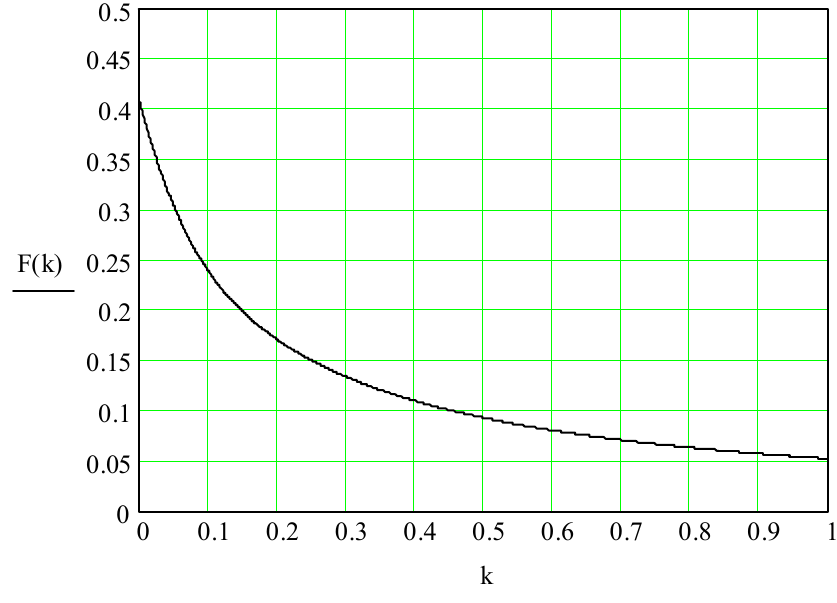
Figure 9. Behavior of function F ( k ) as a function of the parameter k = 0.5 ( 1 + β ) f .